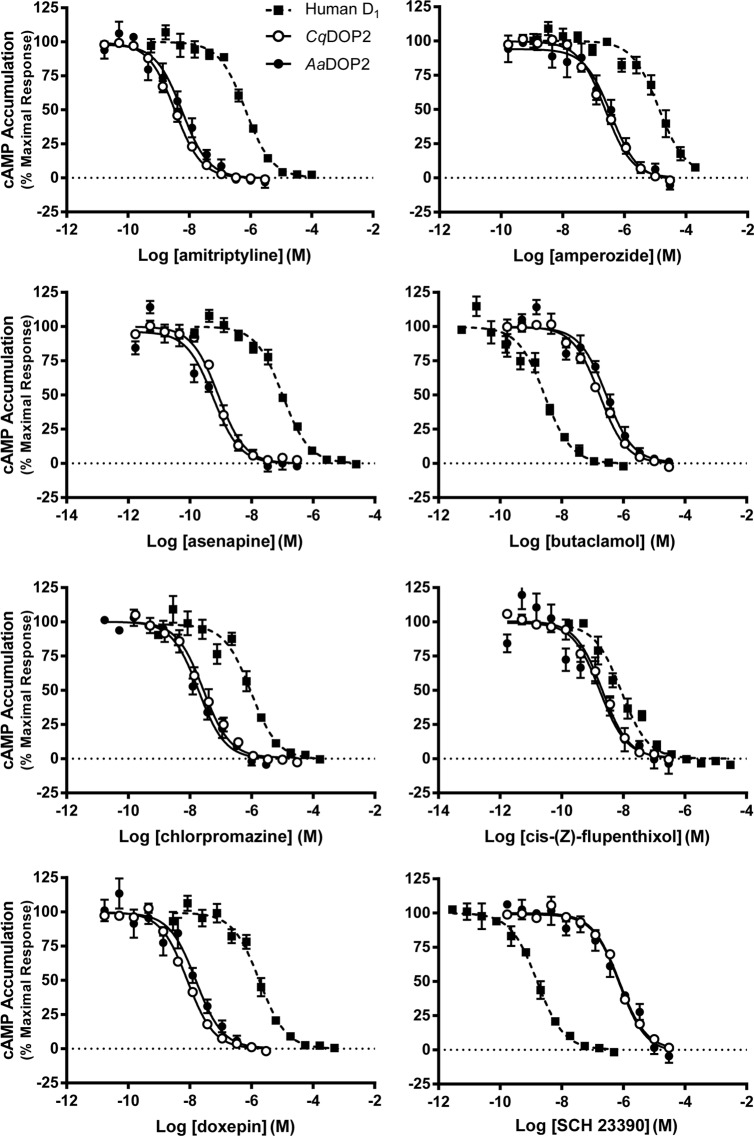
Characterization of select antagonists on receptor activity in HEK cells stably expressing CqDOP (○), AaDOP2 (●), or the human D1 receptor (▪).Graphs are based on compiled cAMP measurements (n ≥ 3 independent experiments) normalized using GraphPad Prism software to the dopamine response for each experiment and shown as mean ± SEM.